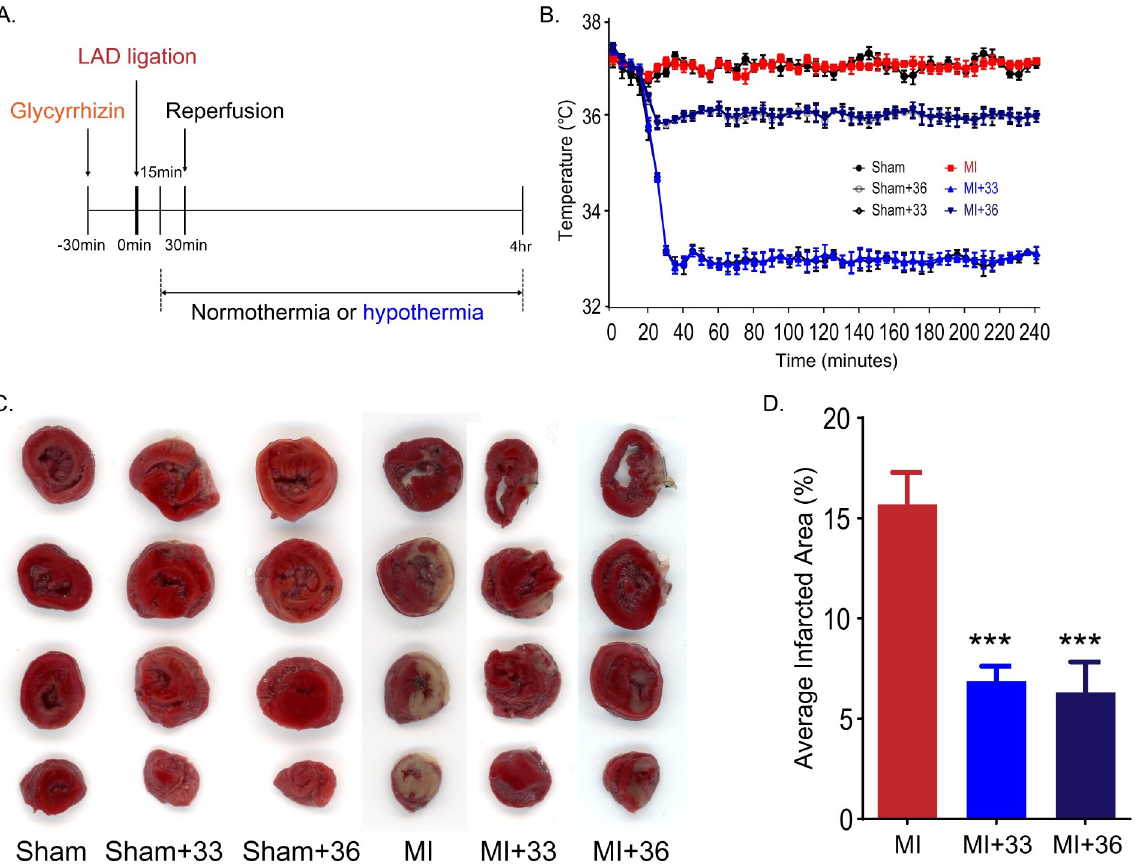
Fig 1. Targeted temperature management at 33˚C and 36˚C similarly reduces infarct volume in myocardial I/R injury. A. Experimental schedule. B. Changes in rat body temperature after LAD ligation (the number of animals: n = 5, respectively). C. Representative image of 2,3,5-triphenyltetrazolium chloride (TTC) staining. D. Volume of myocardial infarction stained with TTC (the number of animals: n = 5, respectively). ��� P < 0.001, comparison of myocardial I/R with normothermia and hypothermia (33˚C and 36˚C), Statistical analyses were performed by one-way analysis of variance (ANOVA) followed by Bonferroni post hoc tests for multiple comparisons between